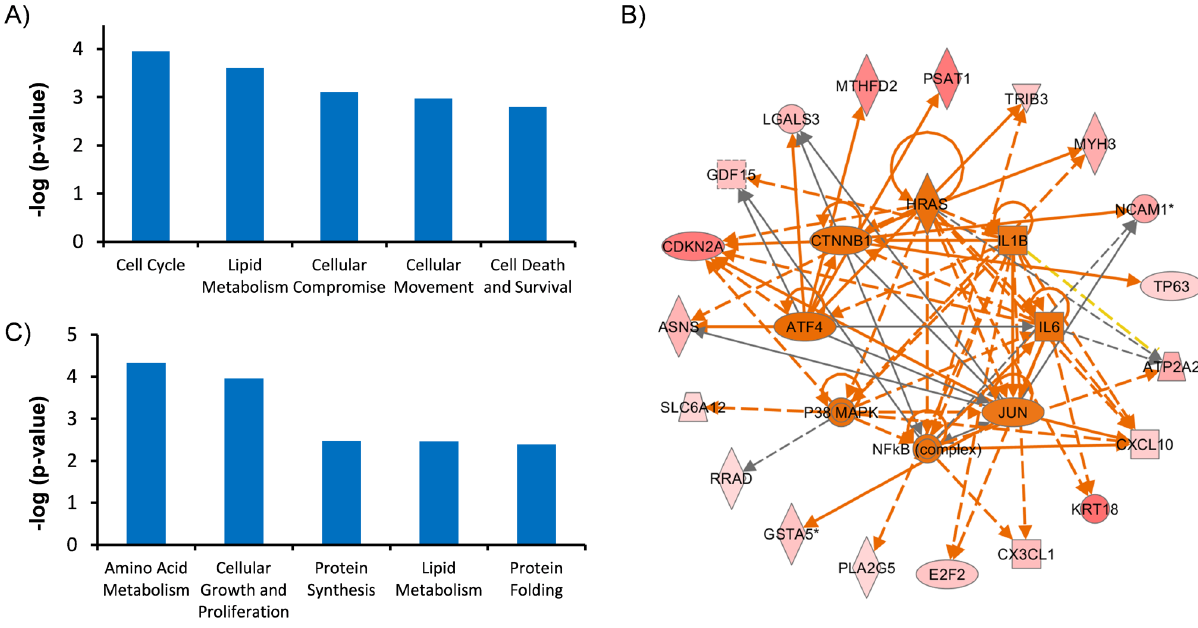
Figure 3. Specific changes in aged and young TauTKO skeletal muscle. A) Biological functions analysis shows a significant activation of cell cycle progression, prostaglandin D2 release, degranulation of cells, cell movement and cell death (necrosis, apoptosis) in aged TauTKO muscle. B) Wheel network diagram showing the overlap of the major upstream regulators of genes chaged in old TauTKO muscles. Each association between genes and upstream regulators is listed in Table 1. Red shapes: upregulated gene, green shapes: downregulated gene, orange shapes: predicted activation, Orange arrows: leads to activation, yellow arrow: findings inconsistent with prediction, gray arrows: effect not predicted. C) Biological functions analysis shows a significant activation of neural amino acid transport, colony formation of cells, protein synthesis, protein folding and steroid content both in young and aged TauTKO muscle compared to age-matched control littermate.